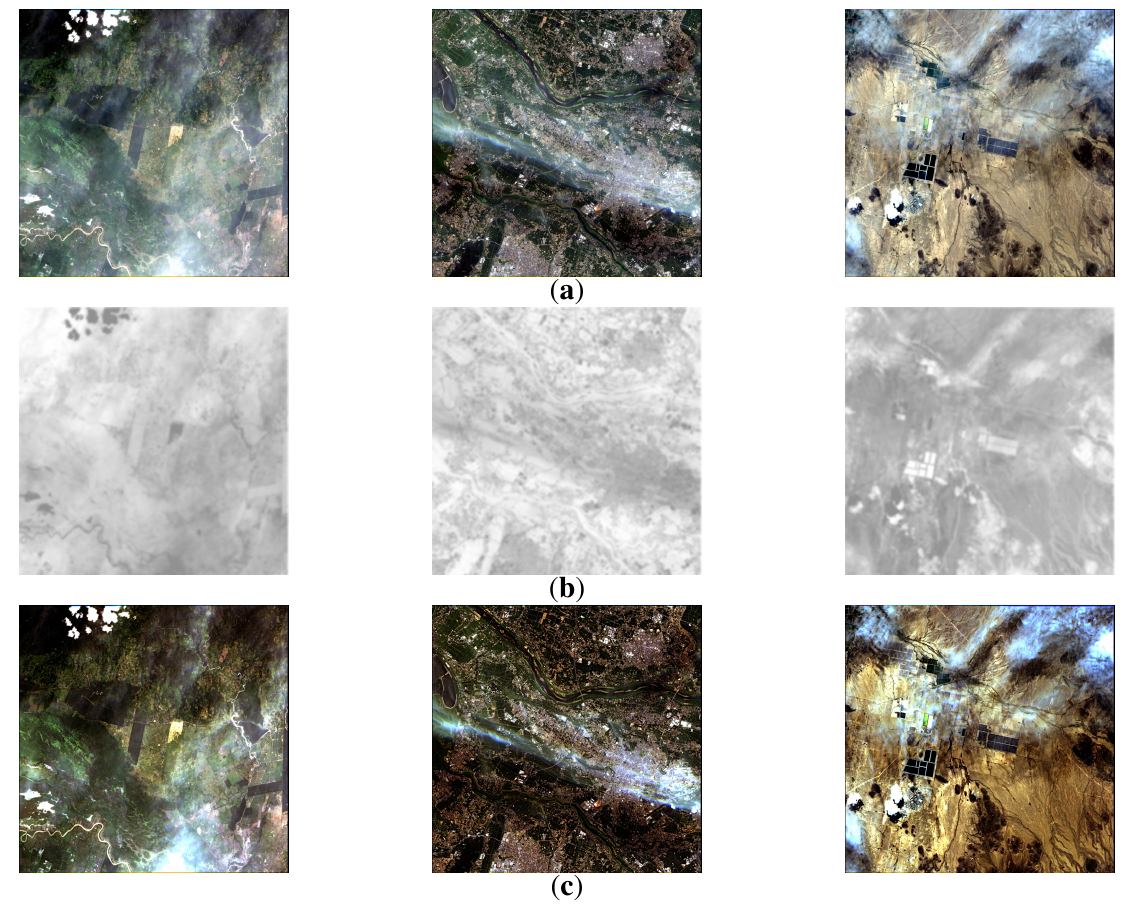
Figure 13. Experimental results of the proposed dehazing method: ( a ) input hazy satellite images courtesy of the Korea Aerospace Research Institute (KARI); ( b ) the modified transmission maps; and ( c ) the dehazed images using the proposed